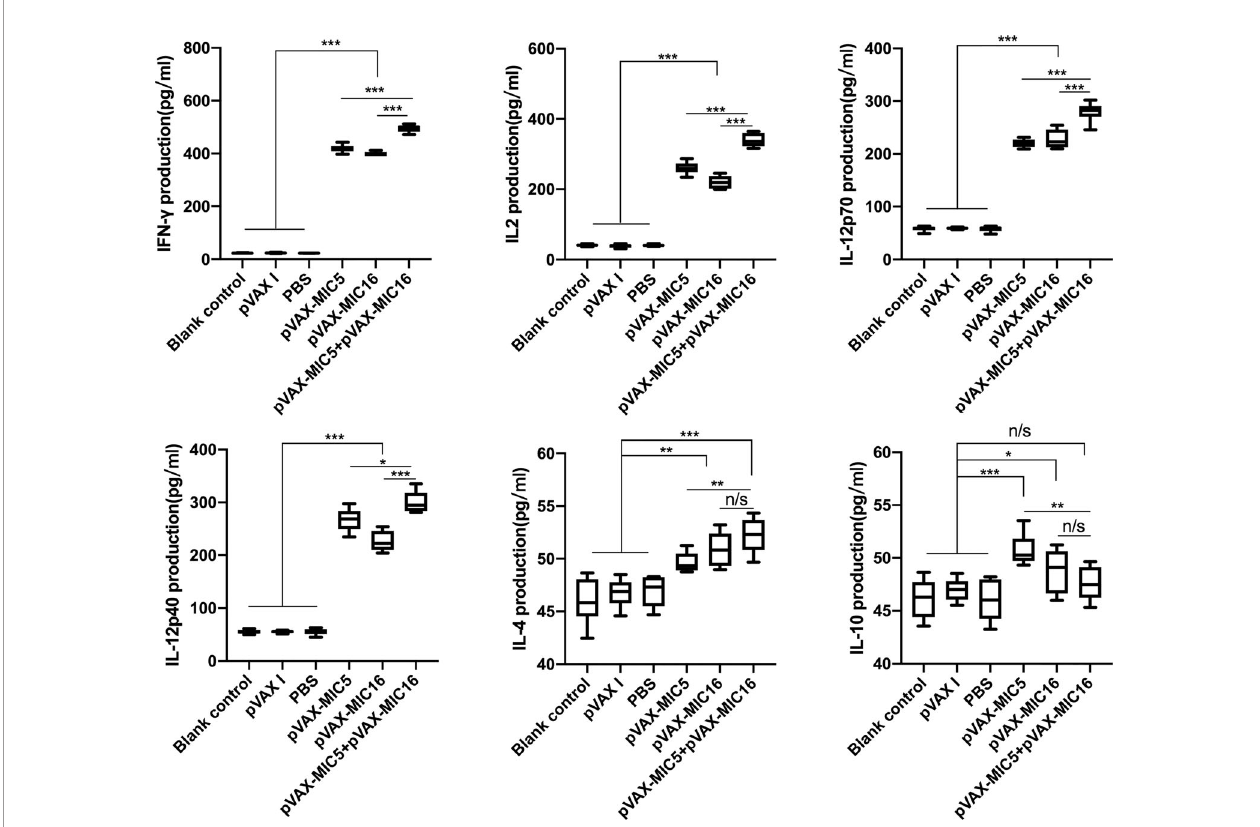
FIGURE 4 | Cytokine production by splenocytes of mice immunized with single or multiple genes. * P < 0.05, ** P < 0.01, *** P < 0.001. “ n/s ” , no signi fi cant. Data are presented as the means ±